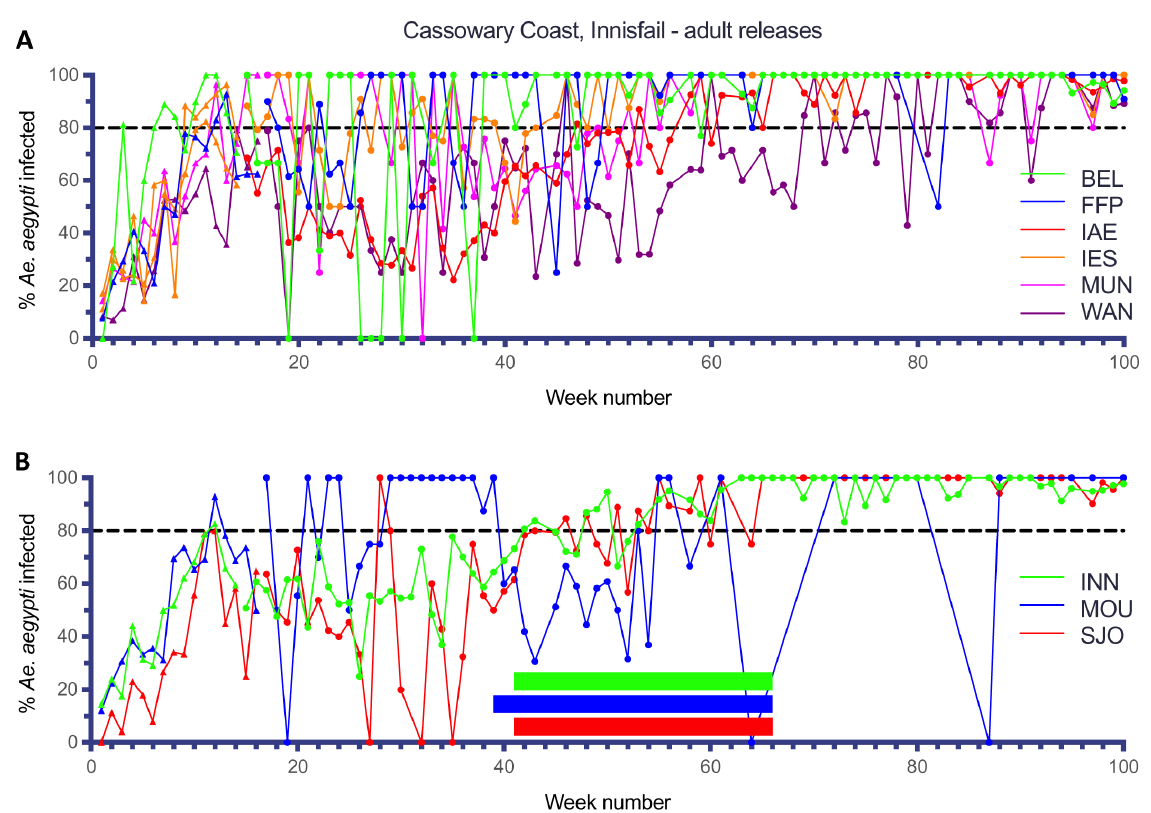
releases).Figure 13. Wolbachia infection rates in Aedes aegypti mosquitoes collected from Belvedere (BEL), Flying Fish Point (FFP), Innisfail East (IAE), Innisfail Estate (IES), Mundoo (MUN) and Wangan (WAN) ( A ) and Innisfail (INN), Mourilyan (MOU) and South Johnstone (SJO) ( B ) during release (triangles) and post-release (circles) monitoring periods ( Wolbachia infected adult releases were undertaken in BEL, FFP, IAE, IES, MUN, WAN, INN, MOU and SJO every week for 14–16 weeks between Mar–Jun 2017, Week number 1 corresponds to commencement of Wolbachia mosquito releases). In INN, MOU and SJO, w AlbB infected male-only Ae. aegypti mosquito releases were undertaken between weeks 41–66 in INN and SJO, and between weeks 39–66 in MOU. Shaded horizontal bars correspond to w AlbB male release period. Estimation of weekly w Mel Wolbachia mosquito infection rates excluded w AlbB males from the